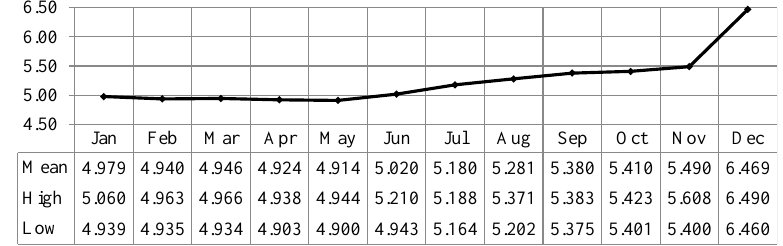
Figure 2. US Dollar 1-month LIBOR rates in 1999 - Telerate Page 3750 Table 2. Computing Uncertainty Coefficients and risk premiums for LIBOR